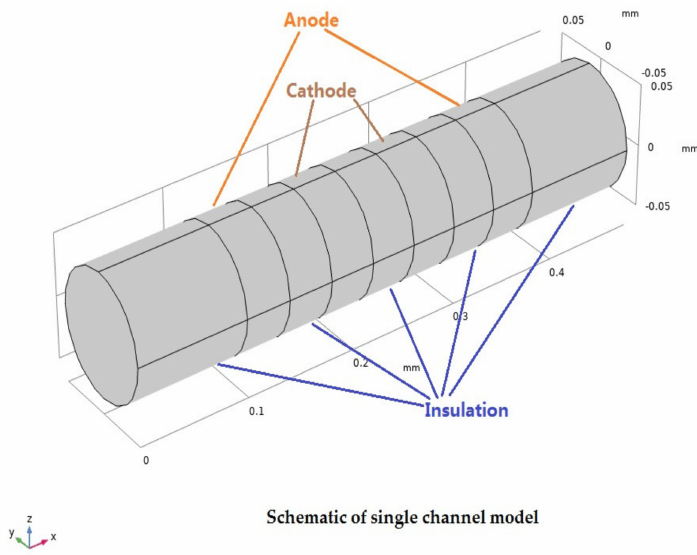
Figure 2. Schematic of a single channel